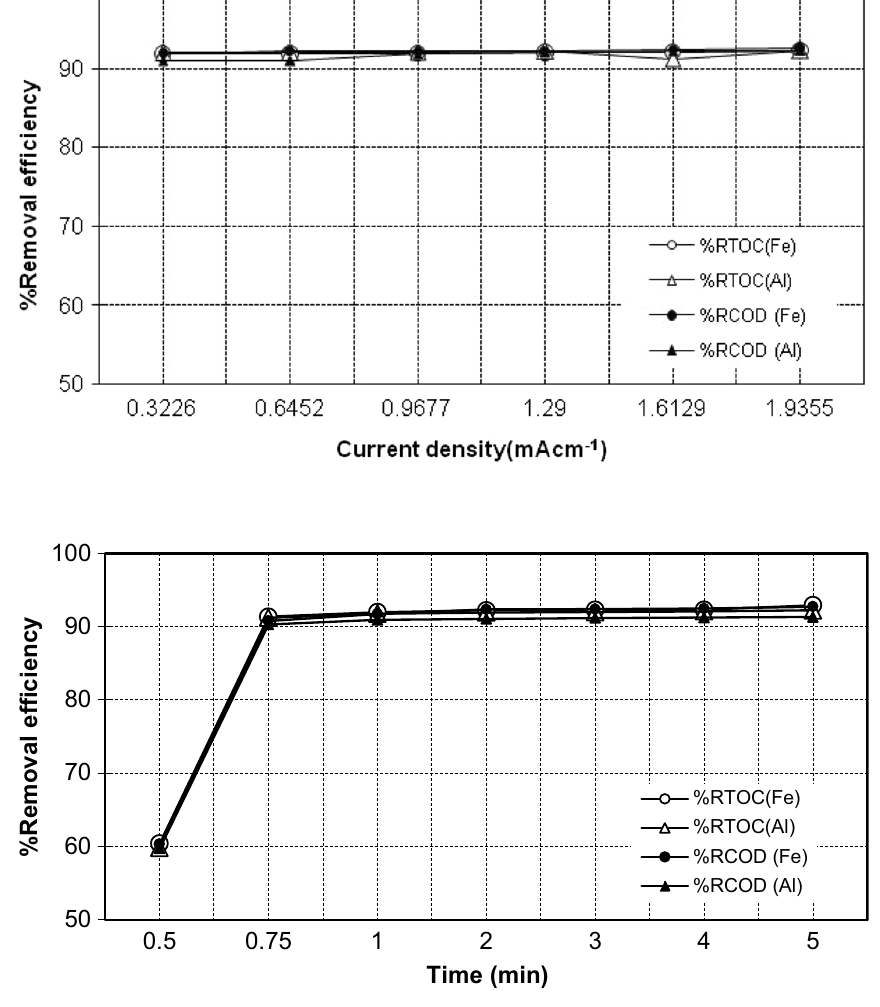
Fig. 4 The effect of current density on the COD and TOC removal by Fe and Al electrode (pH 6; C o,COD = 399,800 mg/L; C t = 1 min; o,TOC = 98,120 mg/L; NaCl = 1 g/L; T = 298 K; agita-